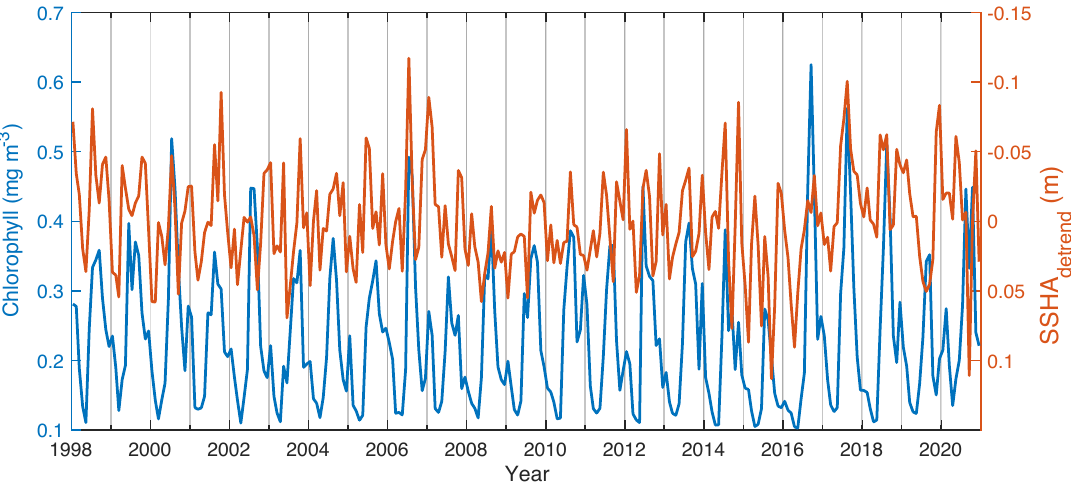
Figure 5. Timeseries of mean chlorophyll versus detrended SSHA in the SLD box.